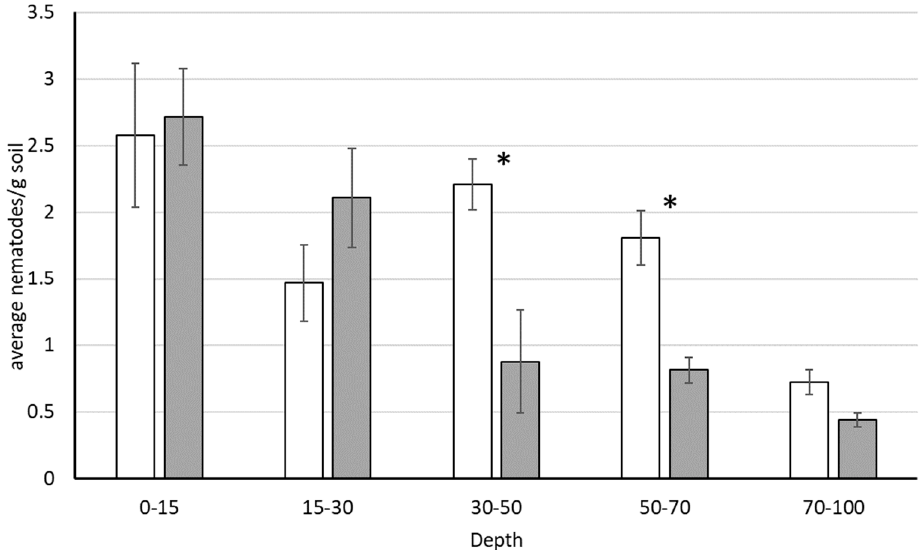
Figure 1. The mean free living nematodes per gram of soil recovered from a Vertosol supporting a cotton-cotton (white) and cotton-maize (grey) rotation to varying depths. Error bars represent the standard error of the means (n = 3) and the asterisks (*) indicate a significant difference between rotation and depth (P = 0.02).